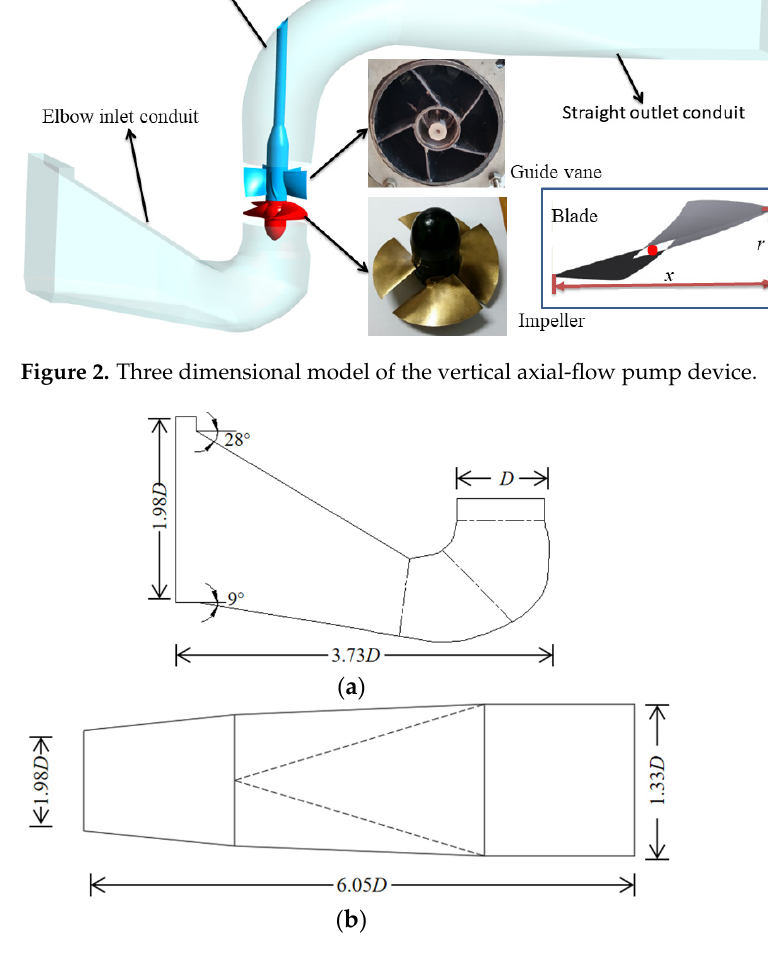
Figure 3. Geometric dimension of the flow conduit. ( a ) Geometric dimension drawing of the elbow inlet conduit. ( b ) Geometric dimension drawing of the straight outlet conduit.